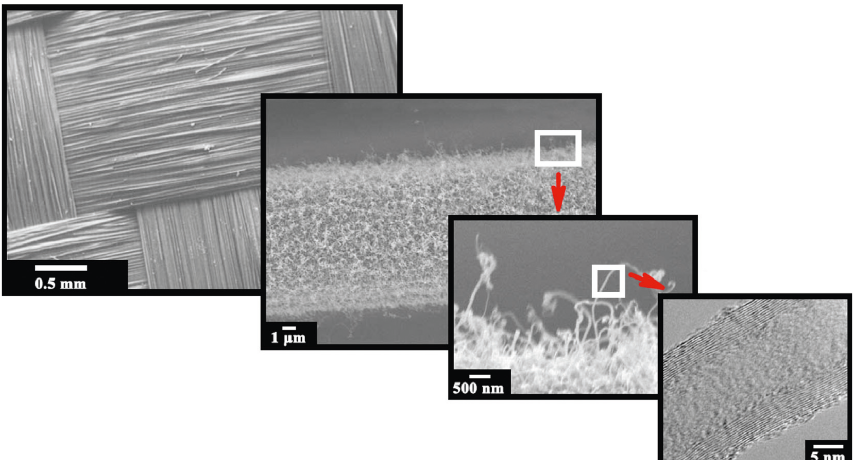
Figure 1: Evolution of the characteristic length scale of reinforcement from millimeters to nanometers: (from upper left to lower right corner) from woven fabric of yarn bundles, to an individual carbon fiber with multiwalled carbon nanotubes grown and entangled on its surface, to such a carbon nanotube (adapted with permission from references [17, 18]; copyright 2005, Elsevier Ltd. and copyright 2002, AIP Publishing